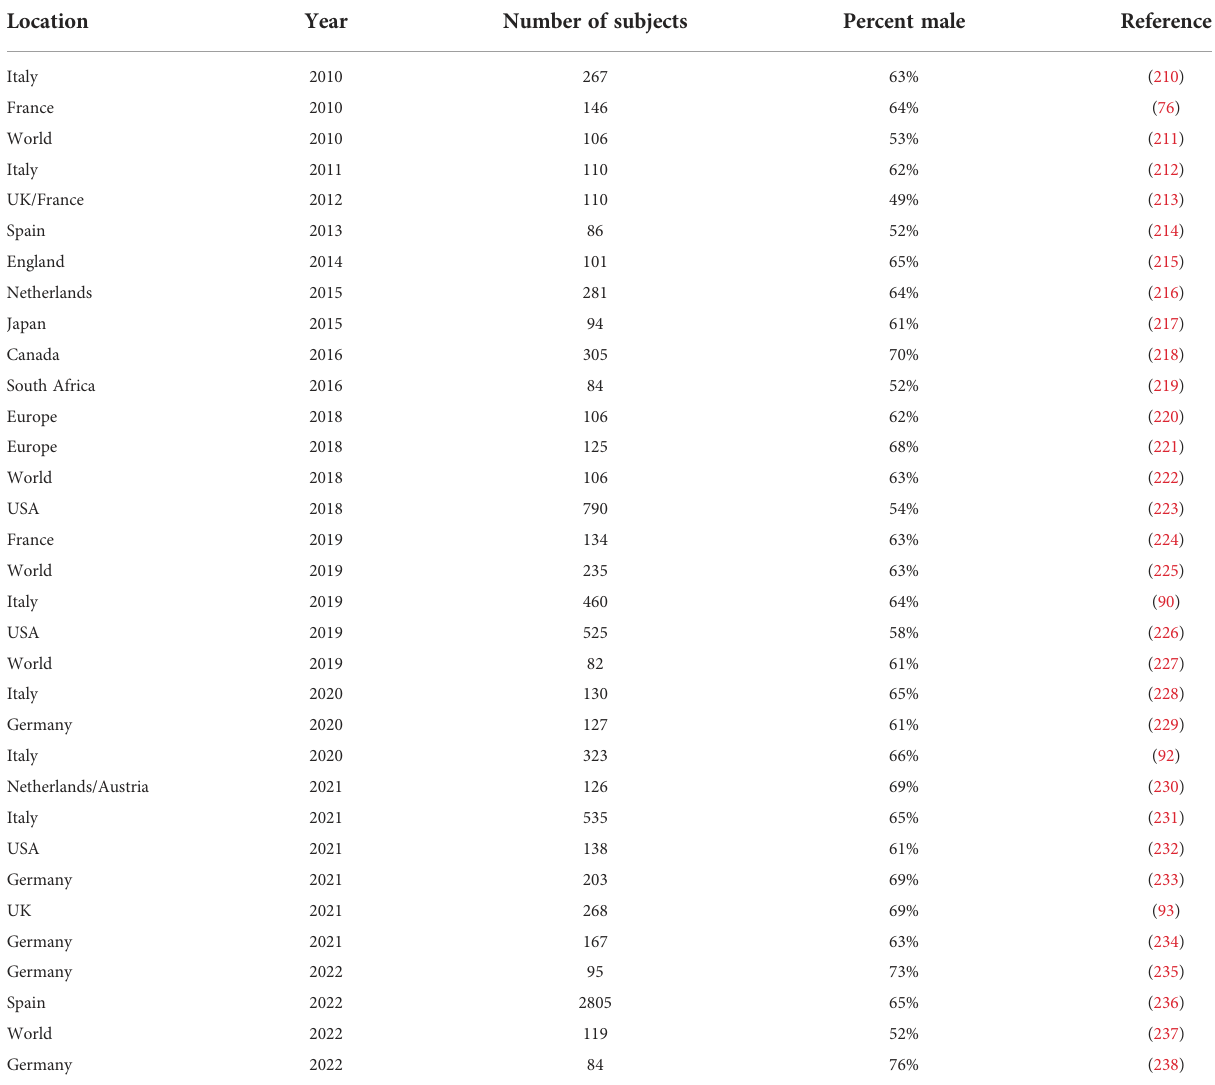
TABLE 6 Percentage of males in a selection of studies of CIDP of 80 or more cases since 2010.